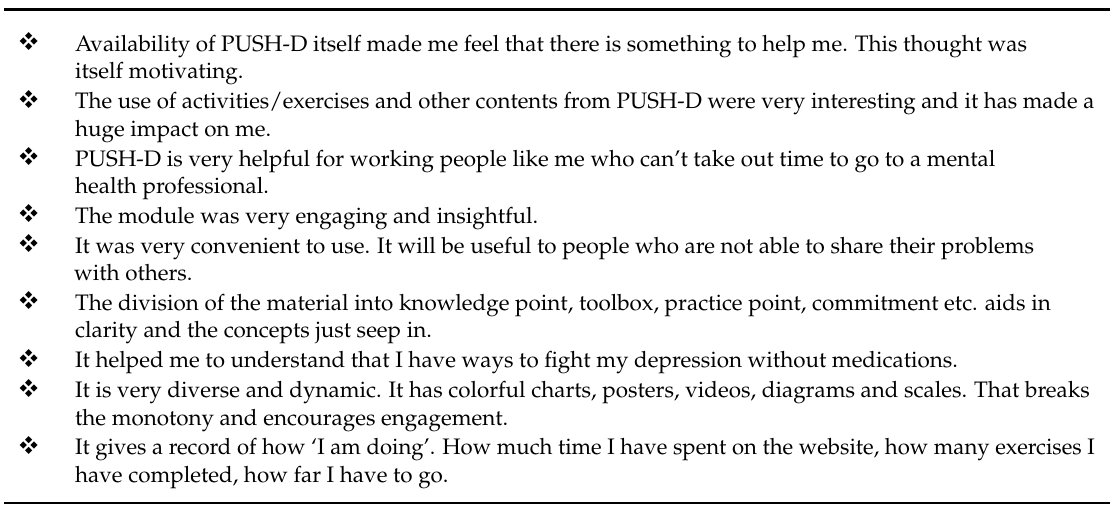
Table 10. Self-perceived gains ( n = 25) from learning based on PUSH-D content (Follow-up assessment). and compassion towards self and